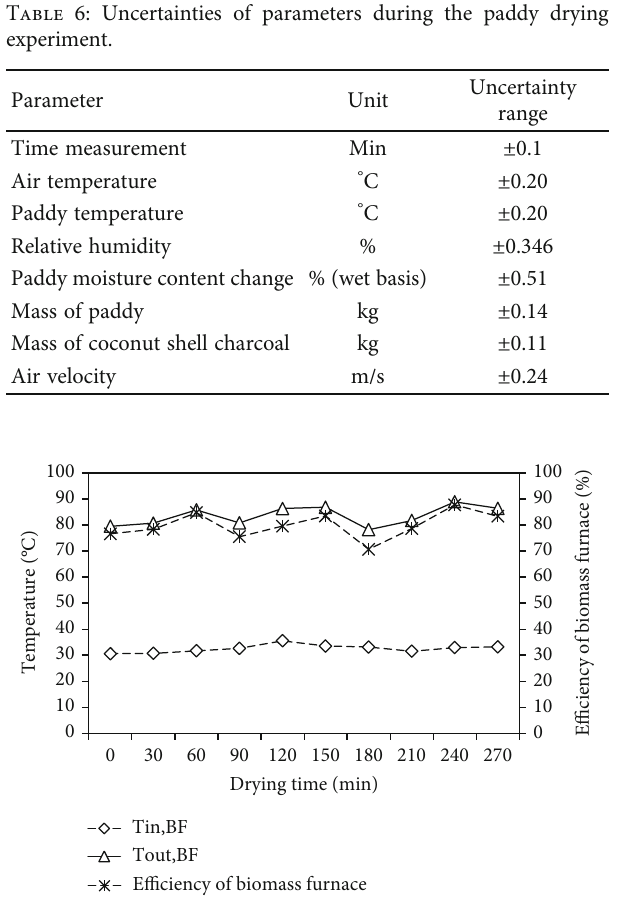
Figure 7: Variation of e ffi ciency of biomass furnace and inlet and outlet temperatures of the biomass furnace with drying time.